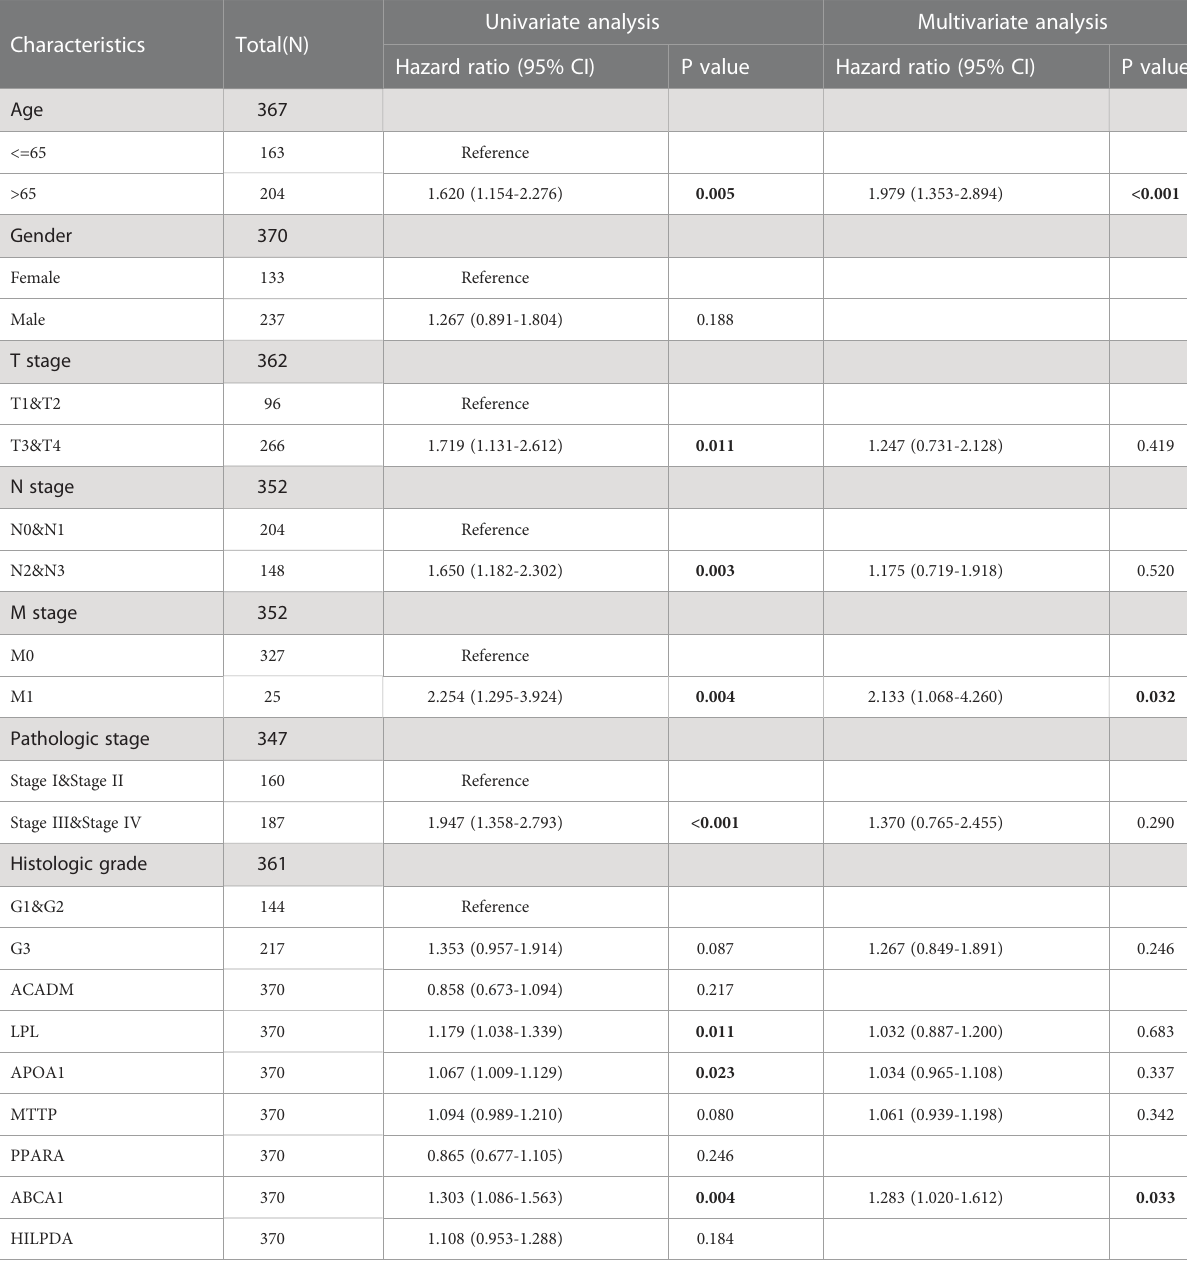
TABLE 1 Univariate and multivariate cox regression analyses were based on multiple clinical characteristics and LDMRGs in the TCGA-STAD cohort.